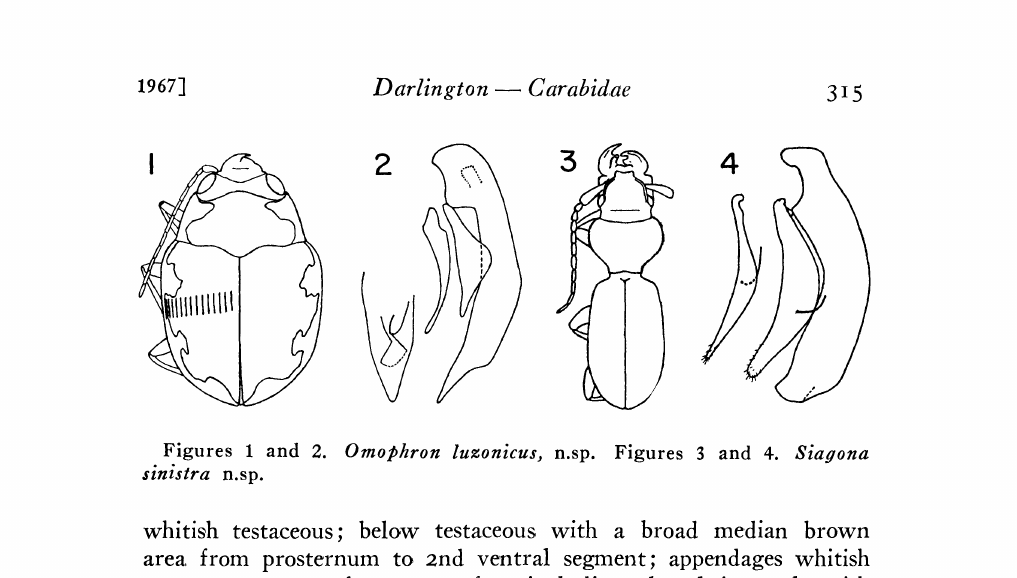
Figures and 2. Omolhron luzonicus, n.sp. Figures and 4. 8iagona sinistra